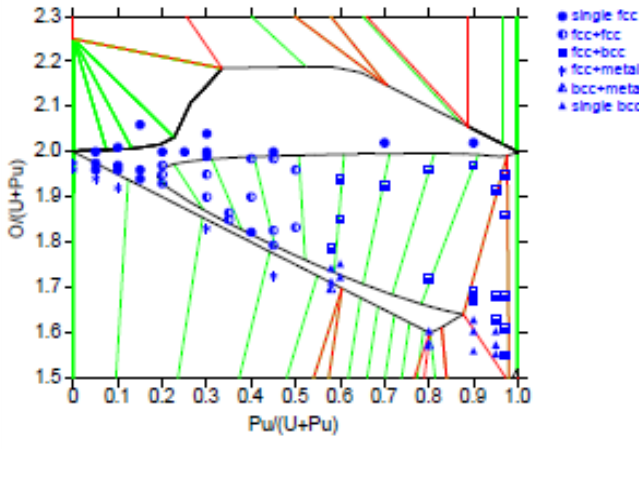
Fig. 1 : U-Pu-O phase diagram at 1273°K. Fig. 2 : U-Pu-O phase diagram at 673°K showing